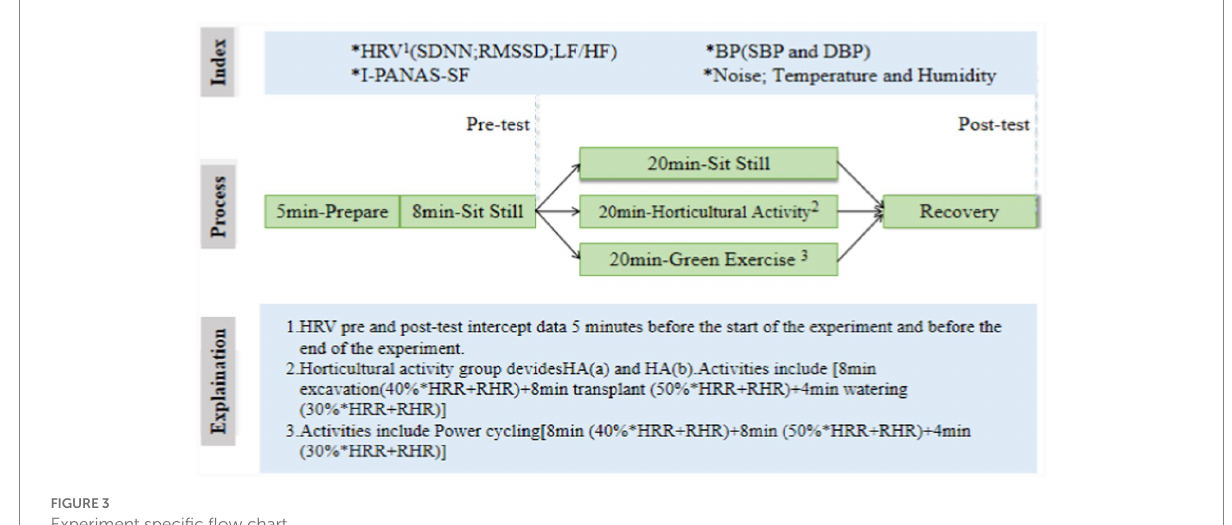
FIGURE 3 Experiment specific flow